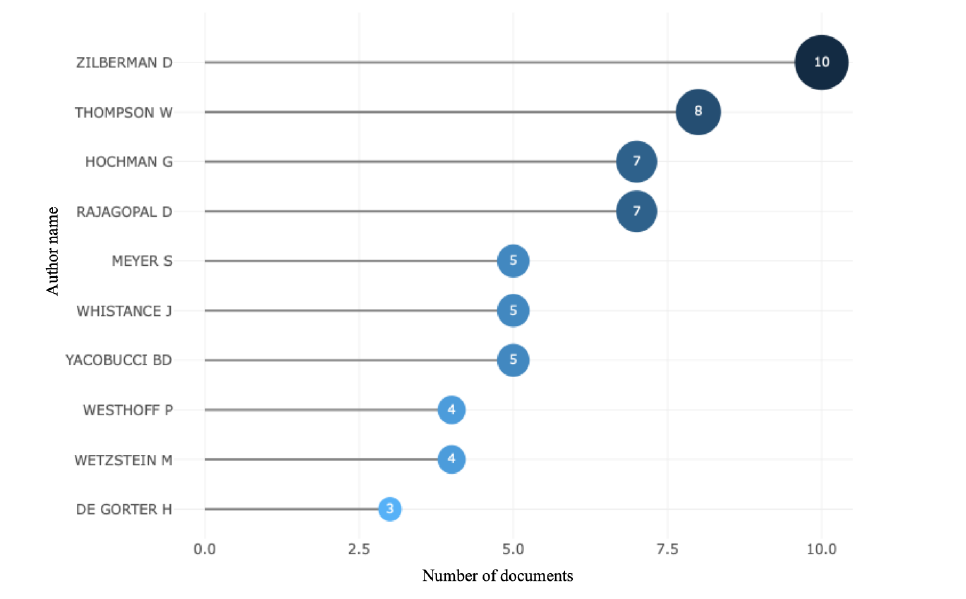
Figure 8. Distribution of citations over time for ten of the most cited articles in the